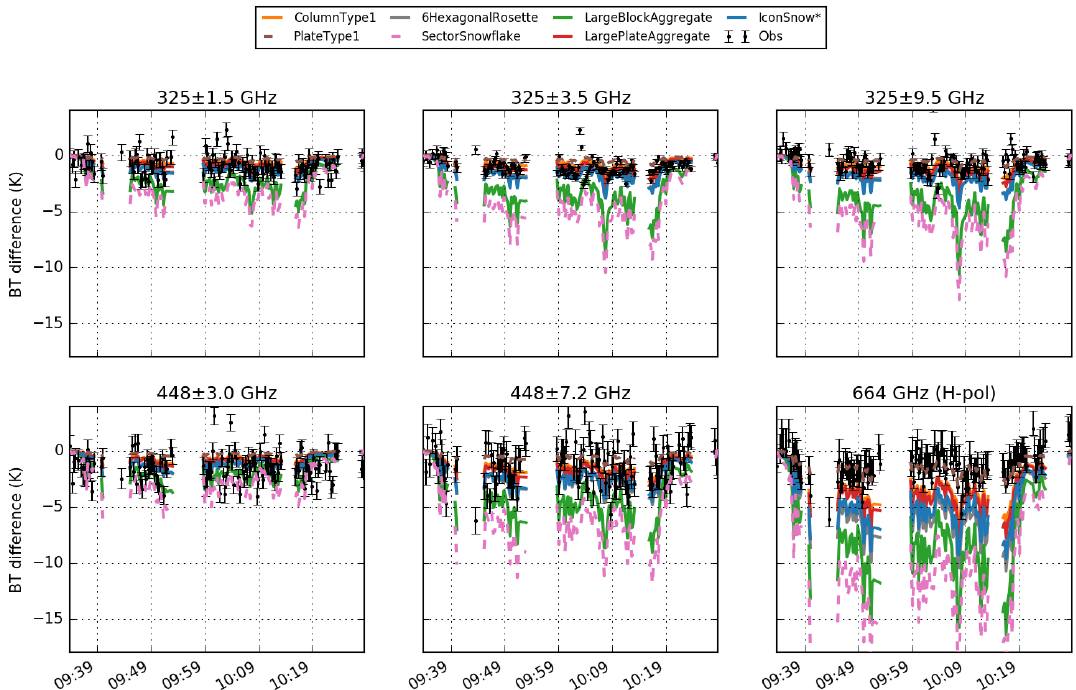
Figure 8. Time series of measured and simulated cloud-induced brightness temperature differences for B895. The dashed lines indicate habits that are not consistent with the in situ bulk mass.